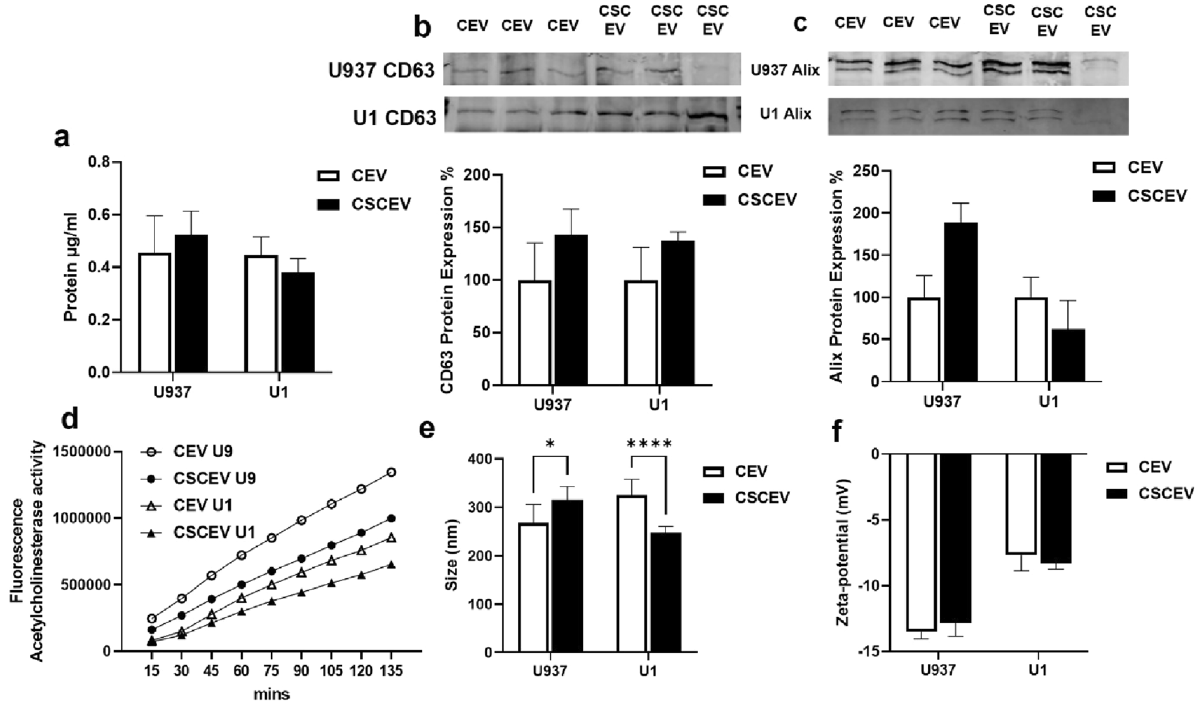
Figure 1. Characterizations of EVs isolated from HIV-uninfected U937 and HIV-infected U1 macrophages after 7 days of treatment with CSC. ( a ) Protein quantification of EVs. ( b , c ) Western blot for EV marker proteins CD63 and Alix using control for each cell as 100%. ( d ) Acetylcholinesterase (AChE) activity in EVs. The activity was measured at different time intervals using arbitrary fluorescence unit. ( e ) Determination of particle size using DLS (Dynamic Light Scattering). EVs derived from U937: Ctrl: 267.2 ± 38.6 nm, CSC treated 316 ± 26.8 nm; EVs derived from U1: Ctrl: 325.4 ± 33.1 nm, CSC treated 247.5 ± 13.4 nm (Mean ± SD). ( f ) Determination of Zeta-potential of EVs. EVs derived from U937: Ctrl: − 13.5 ± 0.5 mV, CSC treated − 12.9 ± 1.0 mV; EVs derived from U1: Ctrl: − 7.7 ± 1.2 mV, CSC treated − 8.3 ± 0.4 mV (Mean ± SD). All the measurements were done in triplicates. CEV represents EVs isolated from the control group; CSCEV represents EVs isolated from the CSC-treatment group. One-way ANOVA was used to find the significance between the control and CSC groups; * indicates p -value < 0.05; *** indicates p -value <